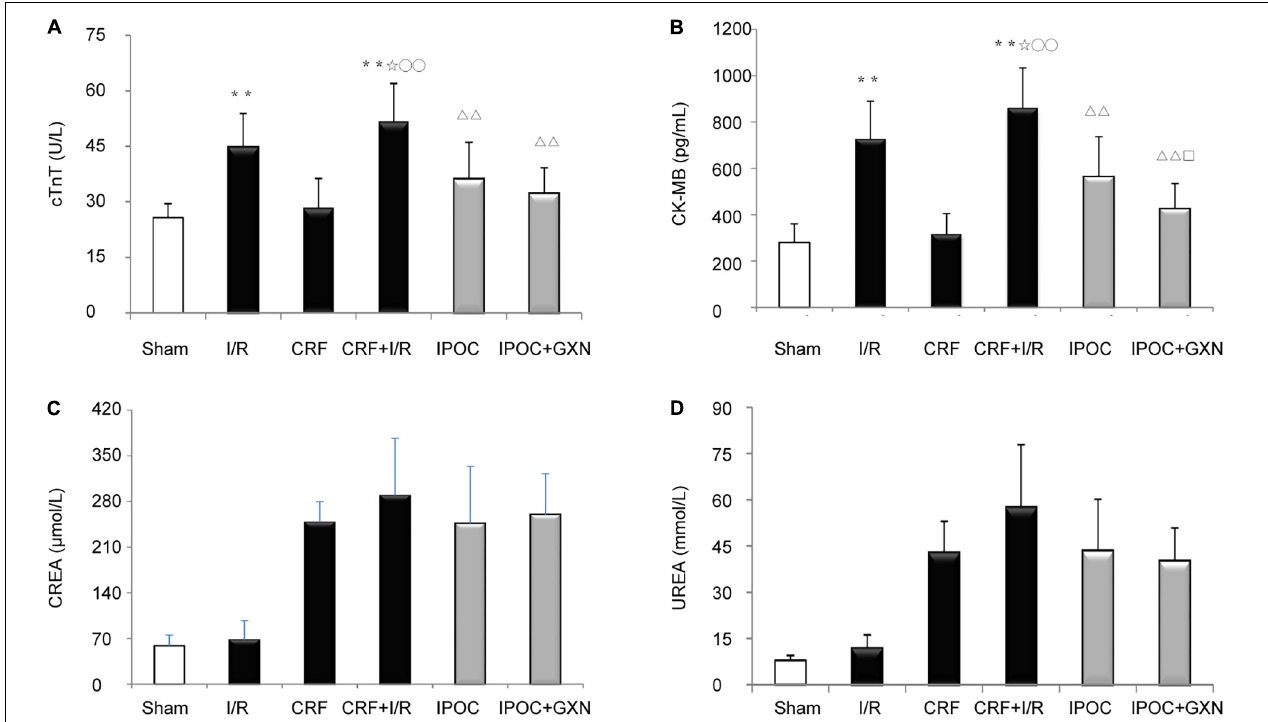
FIGURE 3 | Myocardial injury markers and renal function. (A) cTNT; (B) CK-MB; (C) CREA; (D) UREA. Compared with Sham group, ** P < 0.01. Compared with the I/R group, (cid:73) P < 0.05. Compared with CRF group, (cid:13)(cid:13) P < 0.01. Compared with CRF+IR group, (cid:49)(cid:49) P < 0.01. Compared with IPOC group, (cid:3) P <